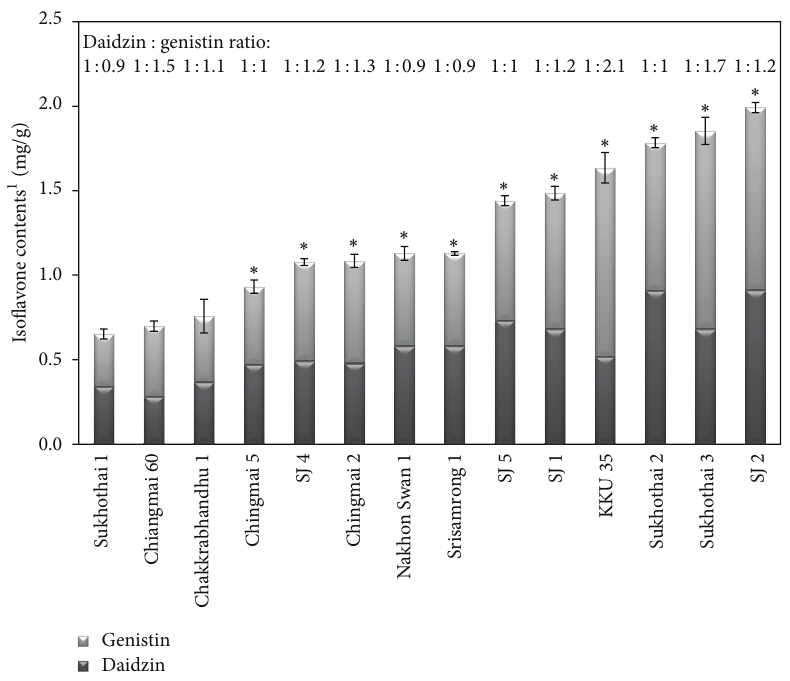
Figure 3: Isoflavone content in sound seeds of 14 soybean varieties planted at SUT Farm on 19 December 2009. Sound seeds of each soybean variety were extracted and assayed in triplicate ( 𝑛 = 3 ). Bars and error bars represent mean ± standard deviation. ∗ 𝑃 < 0.05 compared to